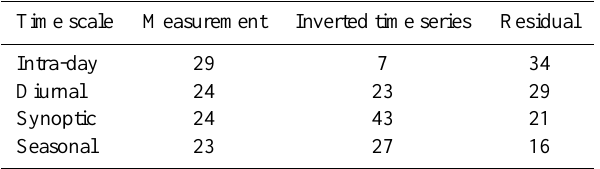
Table 6. Time scale analysis of the measurements, the inverted time series and the residual. This shows the percent of variance in the time series due to components with different time scales. The mea- surements contains variations at all time scales, but the inverted time series does not account sufficiently for hourly